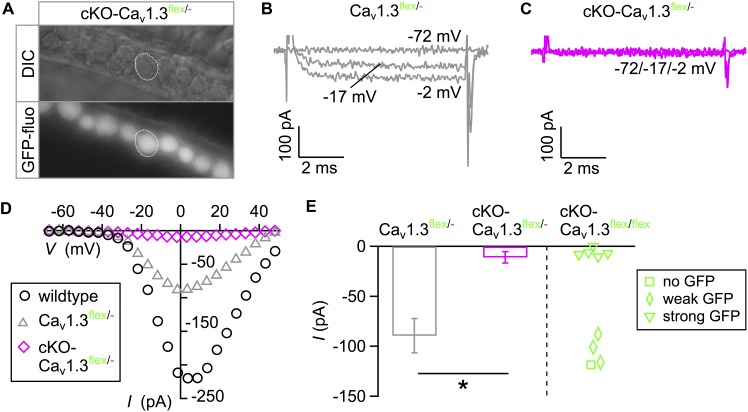
eGFP fluorescence faithfully reflects IBa ablation in IHCs of cKO-Cav1.3flex/- mice. (A) Uniform eGFP fluorescence (bottom) in IHCs (top: DIC image) from an apical cochlear turn of a 3-week-old cKO-Cav1.3flex/- mouse. (B,C) Representative IBa responses to 8-ms step depolarizations of a Cav1.3flex/- control (B) and an eGFP-positive cKO-Cav1.3flex/- IHC (C) to the voltages indicated. (D)
I–V curves corresponding to panels (B) and (C) and a wildtype IHC (Figure 1C). (E) Left: Average peak IBa ± SD of 10 Cav1.3flex/- and 15 cKO-Cav1.3flex/- IHCs (MWU test, ∗∗∗P < 0.001). Right: IBa of individual IHCs with no (square; n = 1), weak (diamonds; n = 3) or strong (triangles; n = 5) eGFP fluorescence from cKO-Cav1.3flex/flex mice.